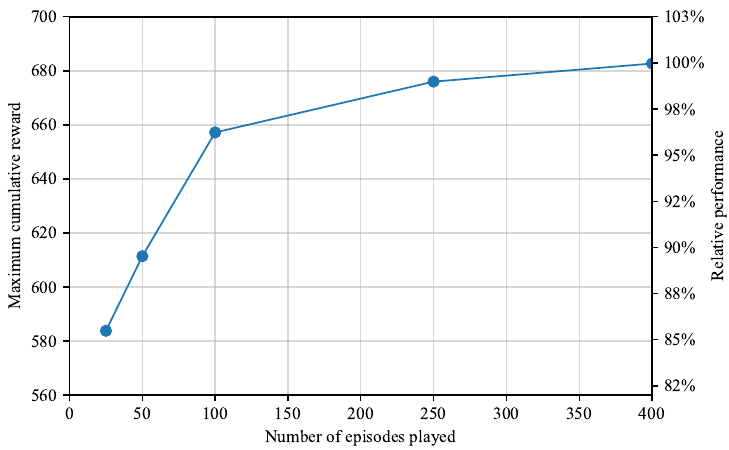
Figure 10. Effect of the number of episodes on the maximum cumulative